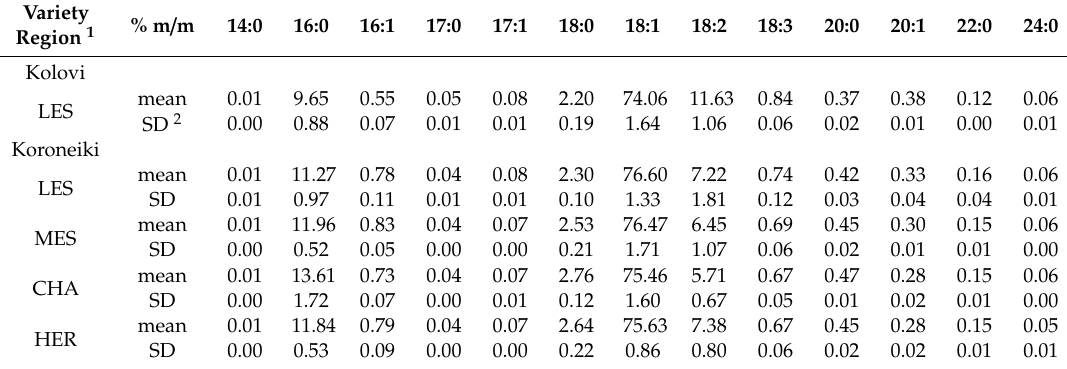
Table 2. Fatty acid composition (% m / m methyl esters) of Greek EVOOs by variety and region. Variety Region